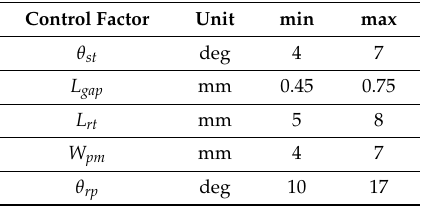
Table 5. Design parameters and ranges for the FSPMM.